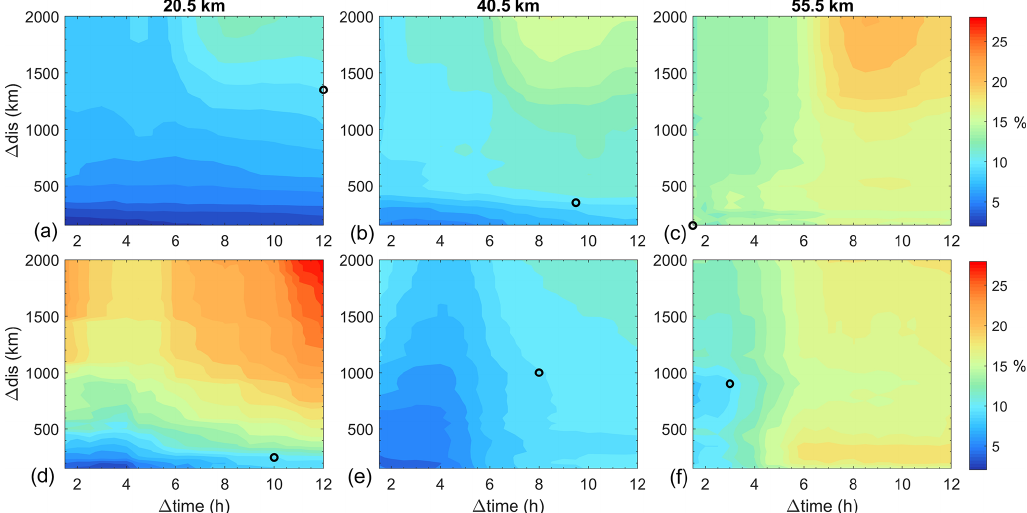
Figure 7. Ensemble mean geophysical variability (2 σ ) between ACE-FTS and OSIRIS O 3 , as estimated from CMAM, EMAC, and WACCM data: (a–c) for 50–90 ◦ N and (d–f) for 50–90 ◦ S. Calculations performed for time difference criteria of within 1.5h to within 12h in 0.5h increments and distance difference criteria of within 150km to within 2000km in 50km increments. Black circles indicate the coincidence criteria optimized for the greatest number of coincident profiles with geophysical variability limited to 10%.